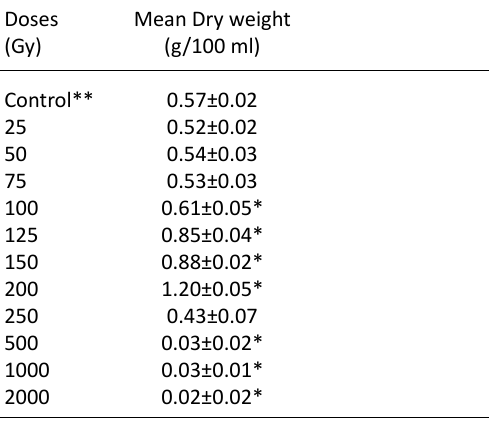
Table 2. Influence of gamma rays on dry weight (g/100 ml) of P. chrysogenum .